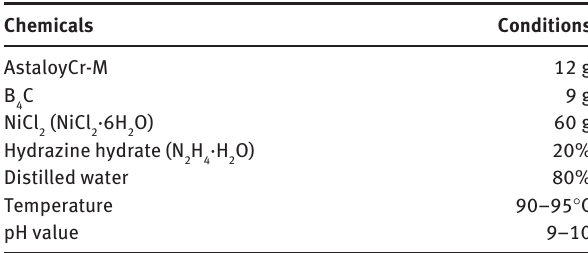
Table 2 Chemicals of Ni plating bath and their ratios.